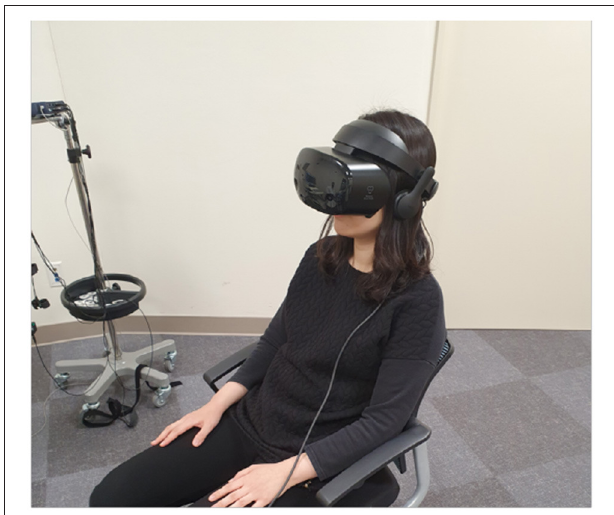
FIGURE 3 | Snapshot of VR relaxation session. VR, virtual reality.